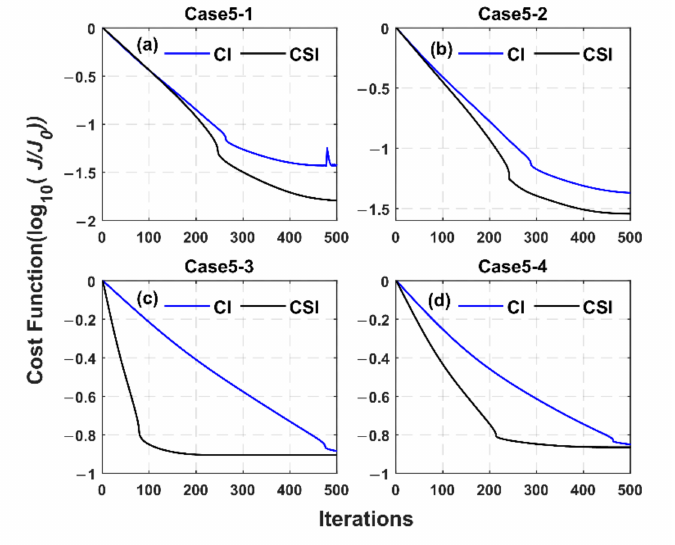
Figure 5. The variation curves of cost functions of the CI scheme and the CSI scheme in Group 2. ( a – d ) correspond to Case 5-1–Case 5-4, respectively.